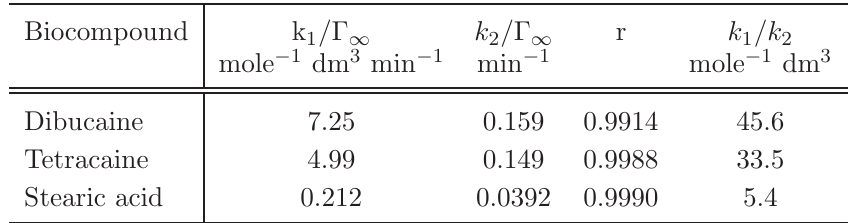
Table 2 Relative adsorption (k 1 /Γ ∞ ) and desorption (k 2 /Γ ∞ ) rate constants derived by Eq. (9) from k values given in Table